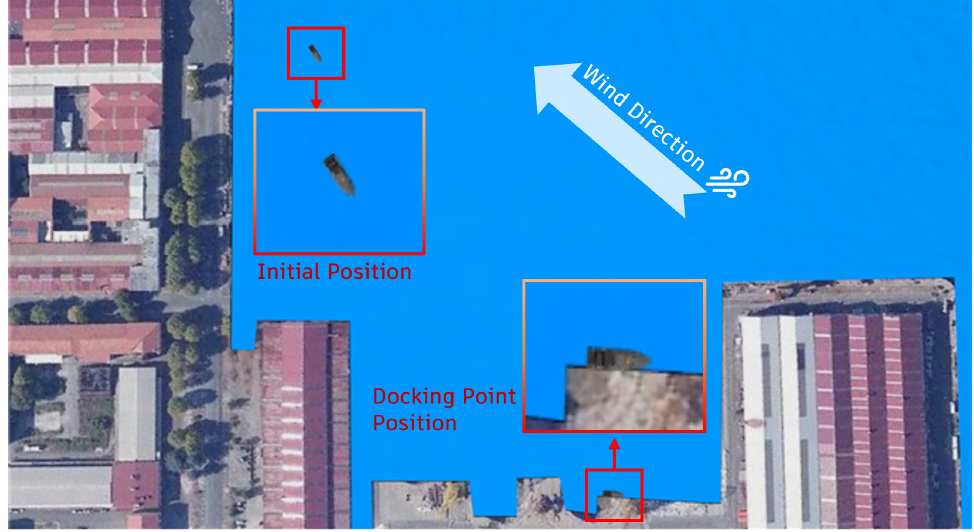
Figure 10. Simulation site, wind direction, and initial/docking position of the